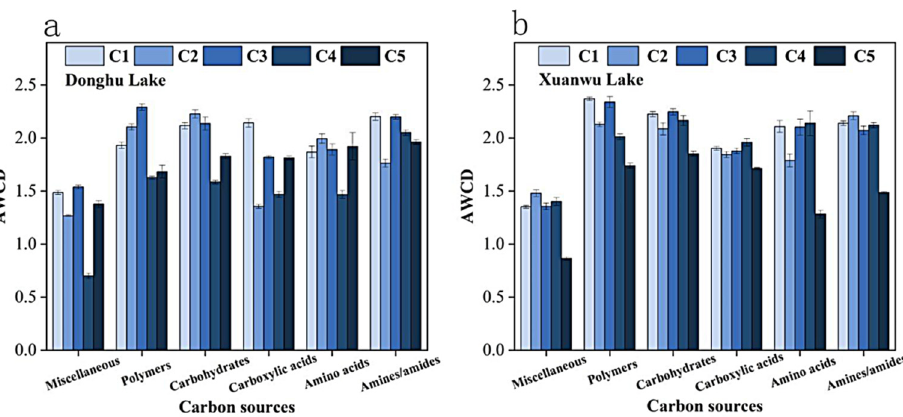
Figure 3. The carbon sources utilization of six carbon source groups between five carriers with different specific surface areas (C1–C5) in two incubation sites, including Donghu Lake ( a ) and Xuanwu Lake ( b ).